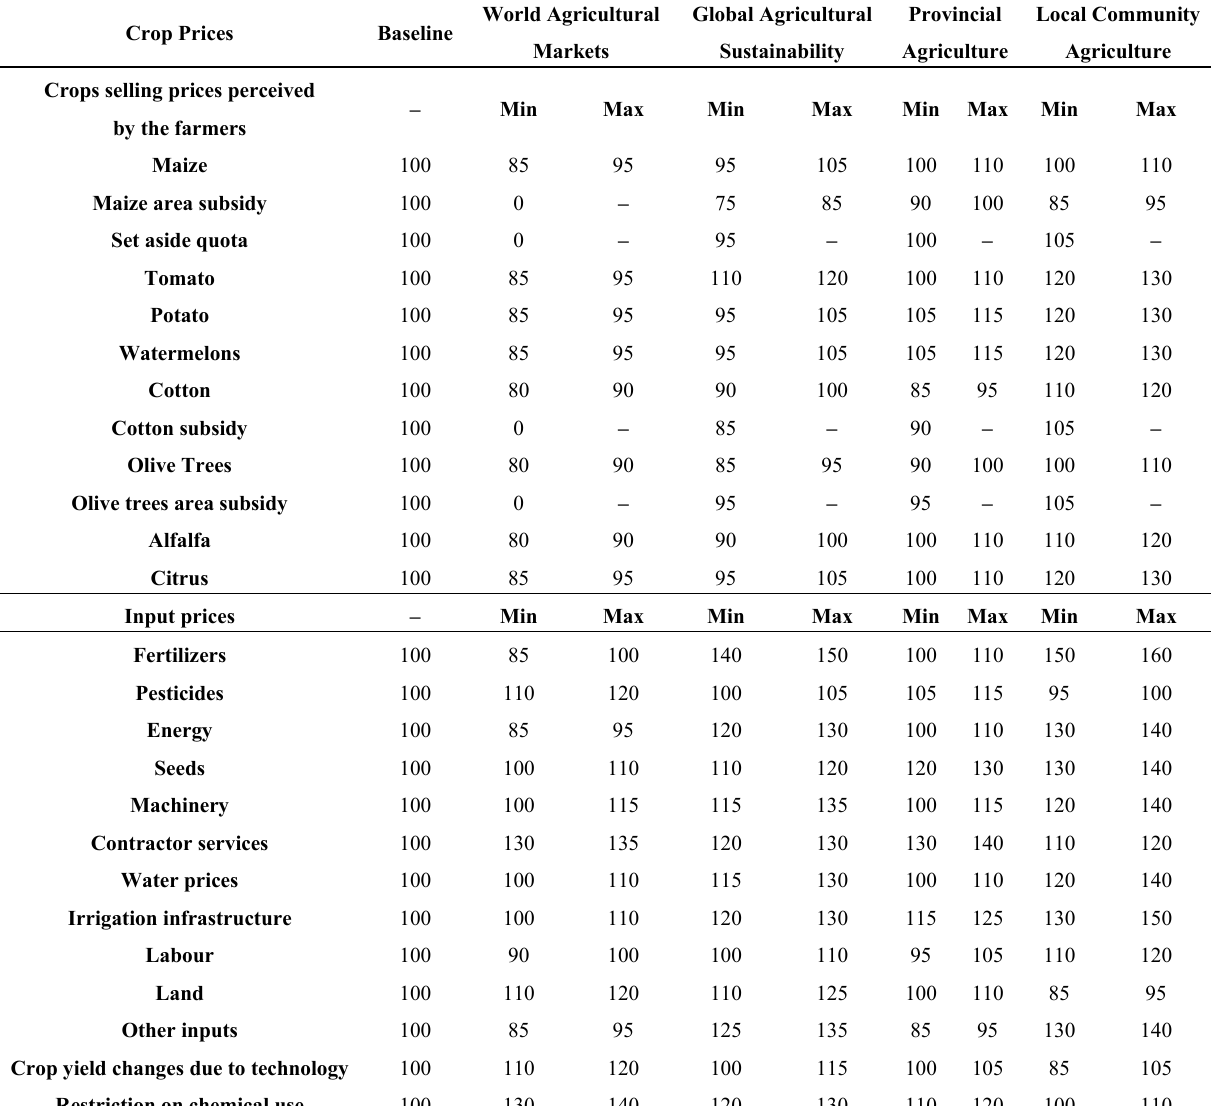
7. Analysis of the Foresight scenarios based on the regional analysis in [39,40]—expressed as a percentage of the baseline year at constant values.